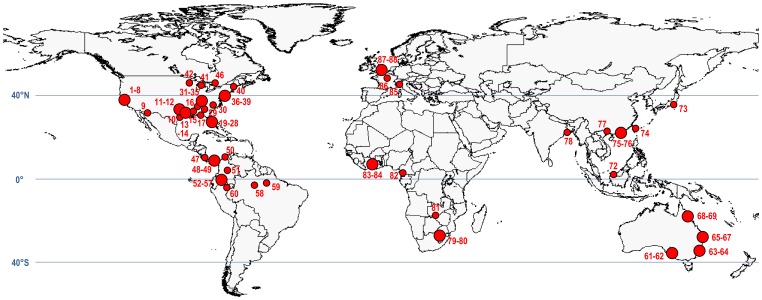
Geographic distribution of fish predation by spiders worldwide.Map depicts locations were spiders were observed predating fish (red dots). Large red dots indicate that several reports originated from same geographic region. Numbers refer to detailed report description (see File S1). GPS coordinates were unavailable for reports #18, 43–45, and 70–71; report # 89 not included.